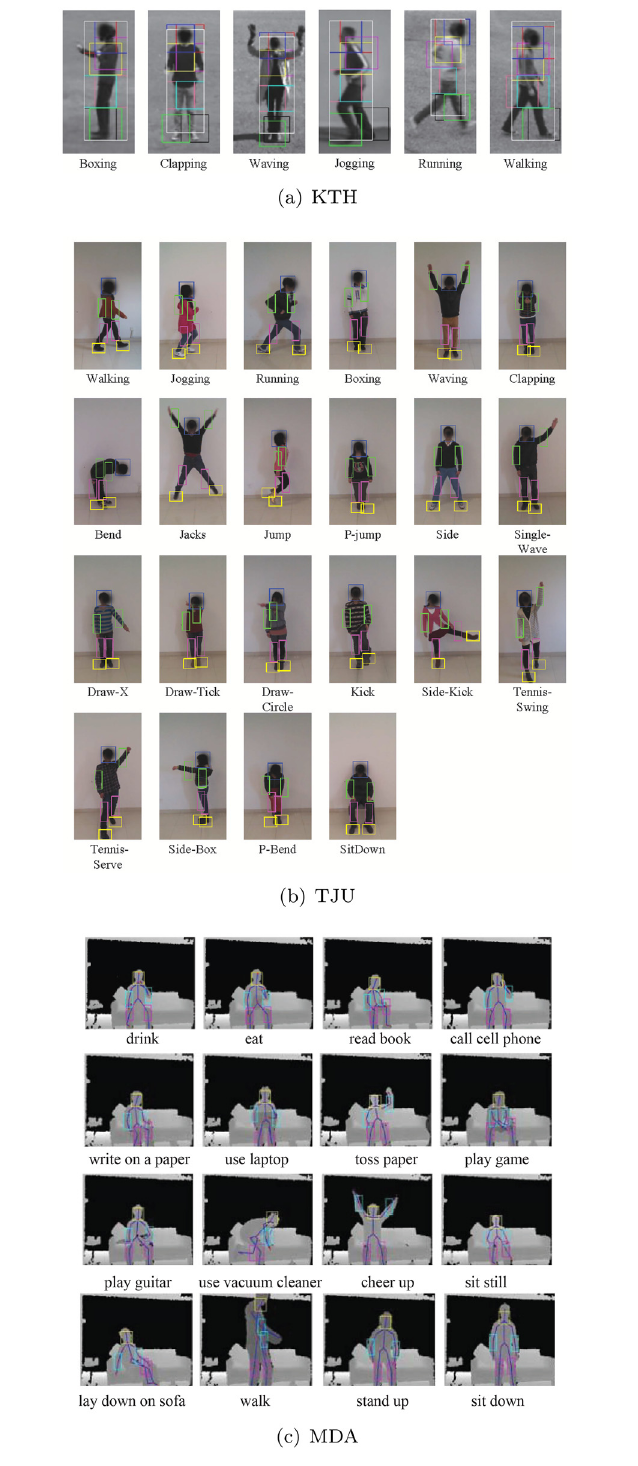
Fig 2. Samples from KTH (a), TJU (b), and MDA